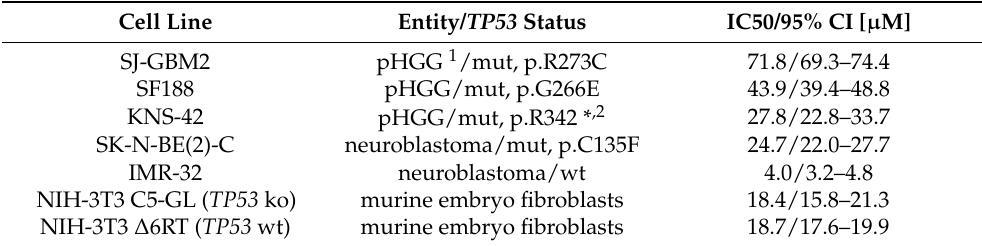
Table 2. Sensitivity to APR-246 in five different pediatric tumor cell models of the nervous system, measured via metabolic activity